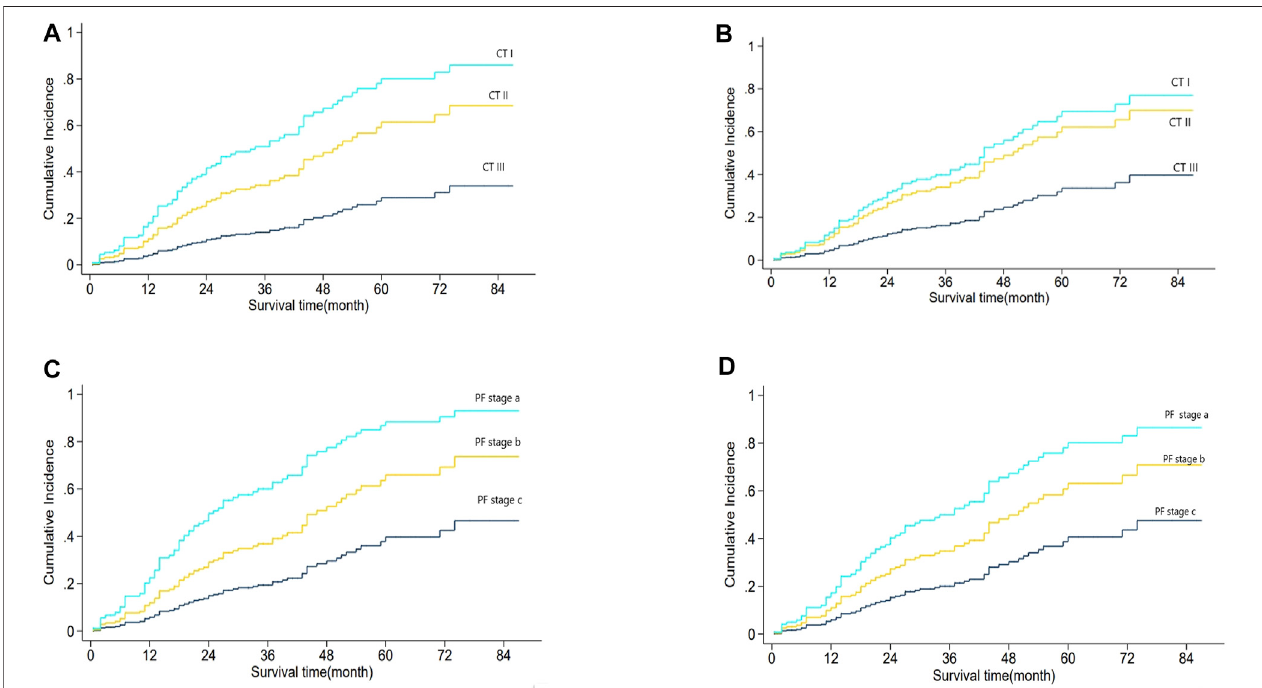
FIGURE3| AnalysisofCTstageandPFgradingandmortality. (A) showstherelationshipbetweenCTstagingandmortalityriskbasedonFine – GrayregressionCT staging univariate analysis, which might be mixed with the in fl uence of PF grade. (B) shows the same relationship in the multivariate analysis of CT staging and PF grading. Adjusted PF grading means the effect of PF grading was eliminated. The results showed that CT stage, with both PF grade adjusted and unadjusted, was positivelycorrelatedwithmortalityrisk. (C) showstherelationshipbetweenPFgradeandmortalityriskbasedonFine – GrayregressionPFgradeunivariateanalysis, whichmightbemixedwiththein fl uenceofCTstaging. (D) showsthesame relationshipbetweenthemultivariateanalysisofCTstaging andPFclassi fi cation. CTstaging adjustedmeanstheeffectoftheCTstagewaseliminated.TheresultsshowthatthePFgrade,withbothCTstagingadjustedandunadjusted,ispositivelycorrelatedwith mortality risk.